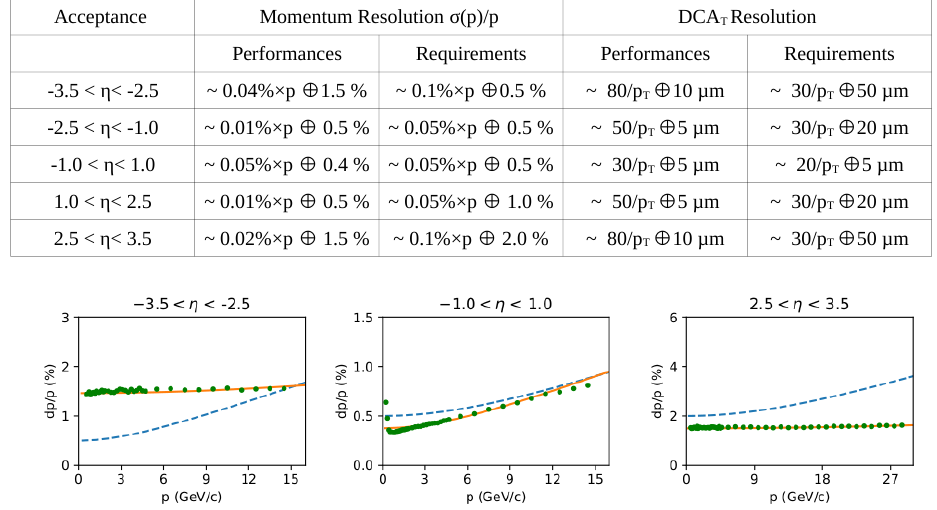
Table 6. Physics requirements on tracking in different bins [1].